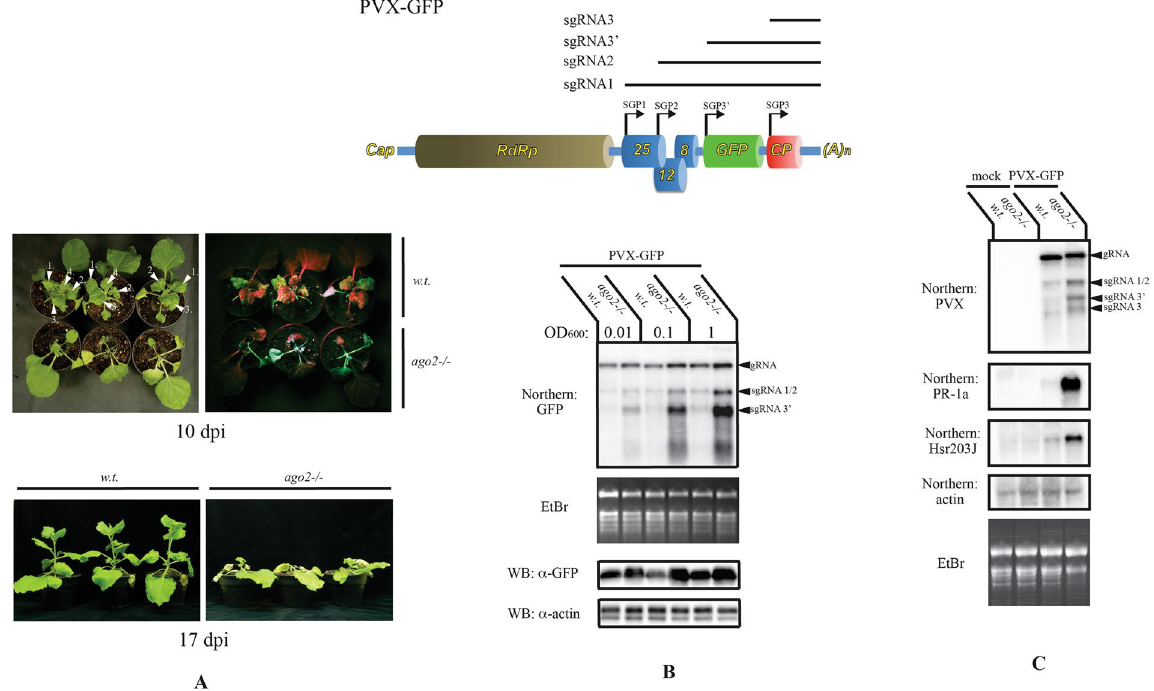
Figure 2. a go2 mutant N. benthamiana plants are hyper-susceptible to PVX infection. ( A ) Photographs of PVX-GFP infected plants. As a sign of recovery new leaves were starting to emerge in wild-type plants, which were generally absent in ago2 plants. On the top left panel white arrowheads point to newly emerging leaves, with higher numbers indicating younger leaves. Picture of the same plants was taken under UV light (top right panel). In the wild-type plants the new leaves exhibited gradually reduced GFP signals with decreasing age. At 17 dpi, wild-type plants show recovery, while in the ago2 plants the apical necrosis usually results in plant death (bottom panel). ( B ) PVX infections of wild-type and ago2 N. benthamiana plants were initiated from a leaf-infiltrated Agrobacterium strain carrying a PVX-GFP encoding binary vector. Different dilutions of the bacterium suspension were infiltrated into the leaves. Concentrations of the suspensions are given as optical densities measured at 600 nm (OD 600 ). At 5 dpi, total RNA and protein lysates were prepared from the first symptomatic non-inoculated leaves. Samples were collected from three plants and pooled. Viral RNA levels were monitored in northern blot using a GFP probe. Viral genomic and subgenomic RNAs are indicated by arrowheads (top panel). Ethidium-bromide (EtBr) stained gel is shown as loading control (second panel). Virus encoded GFP protein levels were analyzed by western blot (third panel). The same blot was developed with an actin antibody to verify equal loading (bottom panel). ( C ) Induction of defense related genes in PVX infected plants were monitored by northern blot. RNA samples were prepared from systemically infected leaves at 7 dpi. Samples were pooled from three plants. Actin probe hybridized filter and Ethidium-bromide stained gel are shown as loading controls. Arrowheads indicate PVX genomic and subgenomic